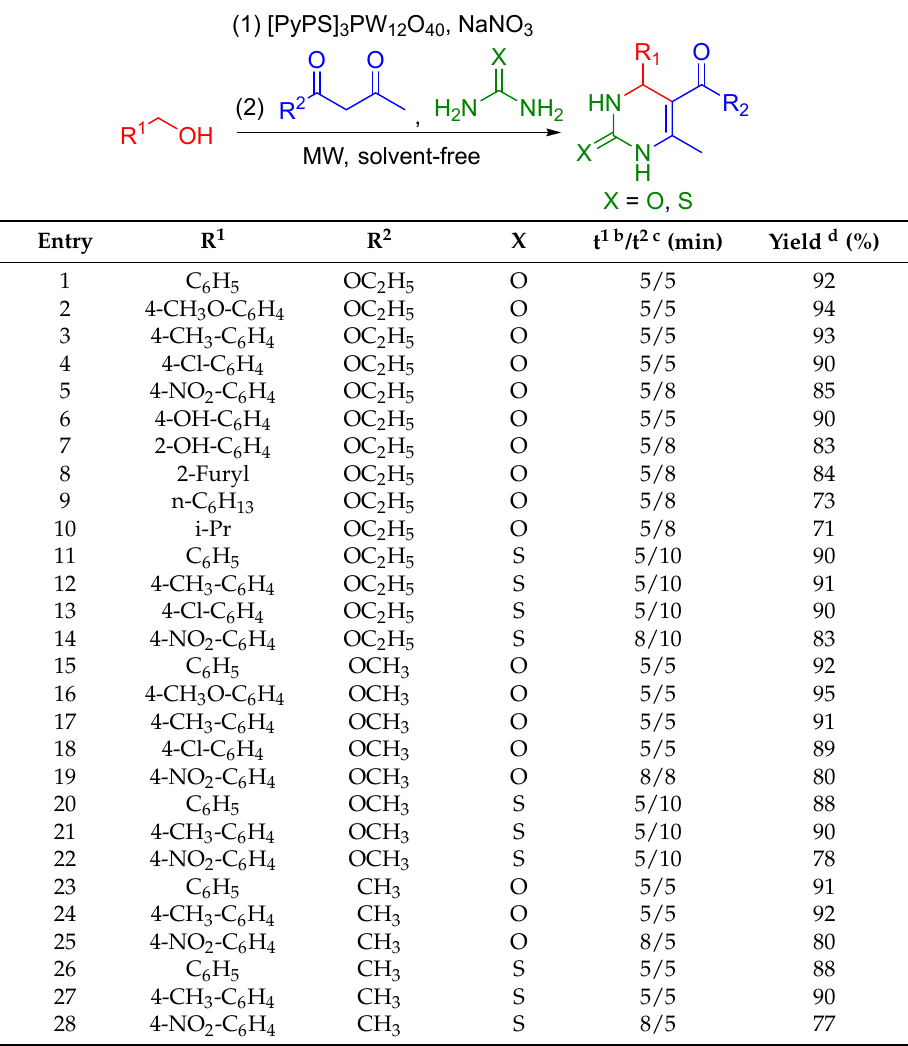
Table 2. Scope of the Biginelli reaction starting directly from alcohols.